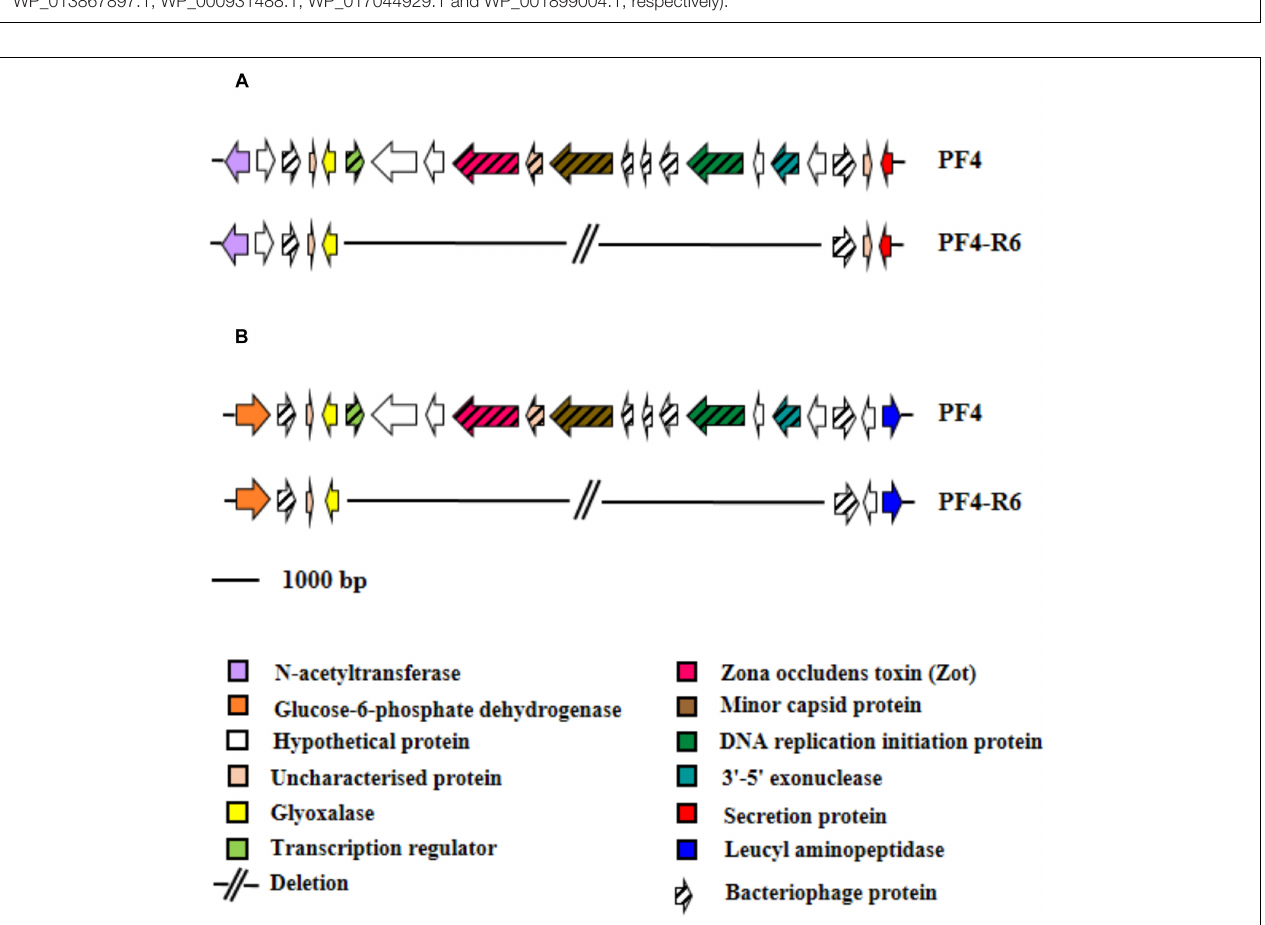
FIGURE 9 | Schematic representation of the distribution of specific mutations in phage-resistant strains of V. anguillarum . Genes are represented as arrows, deletion mutations are represented by short lines, term of the chromosome is represented by perpendicular line and phage proteins are represented by arrow with thick line. Functions for genes are shown in colored boxes. Specific region that presented a large deletion in PF4-R6 strain. (A) Chromosome I (accession numbers). (B) Chromosome II (accession numbers WP_019820677.1, WP_006880472.1, WP_017041958.1, WP_019281837.1, WP_017049549.1, WP_017041960.1, WP_017049548.1, WP_017049547.1, WP_017049546.1, WP_017049545.1, WP_009706113.1 and WP_017049544.1, respectively).